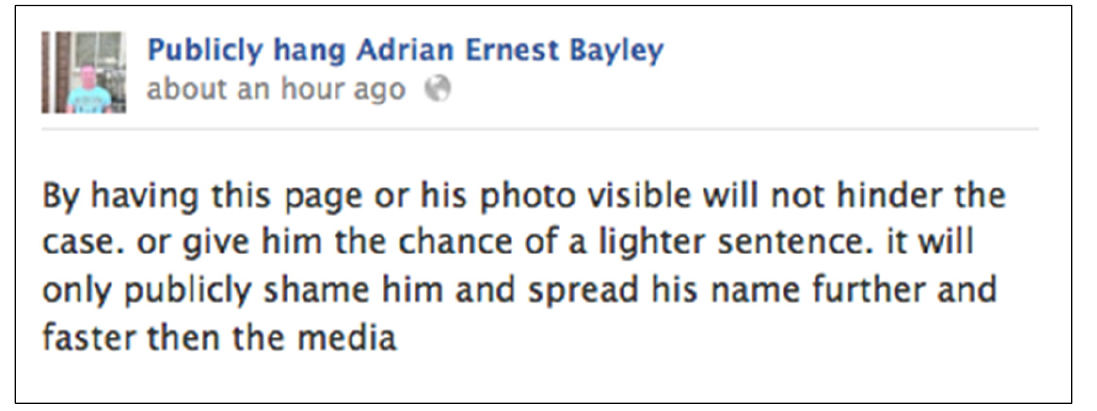
Figure 3: ‘Justification’ for showing the accused’s photo posted by the creator of a Bayley ‘hate